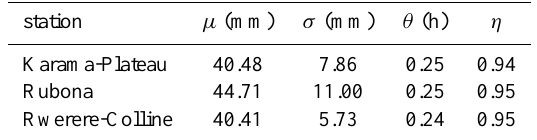
Table 2. Optimized values of the parameters of the IDF-curves i T,d for the stations Karama-Plateau, Rubona and Rwerere-Colline in Rwanda.